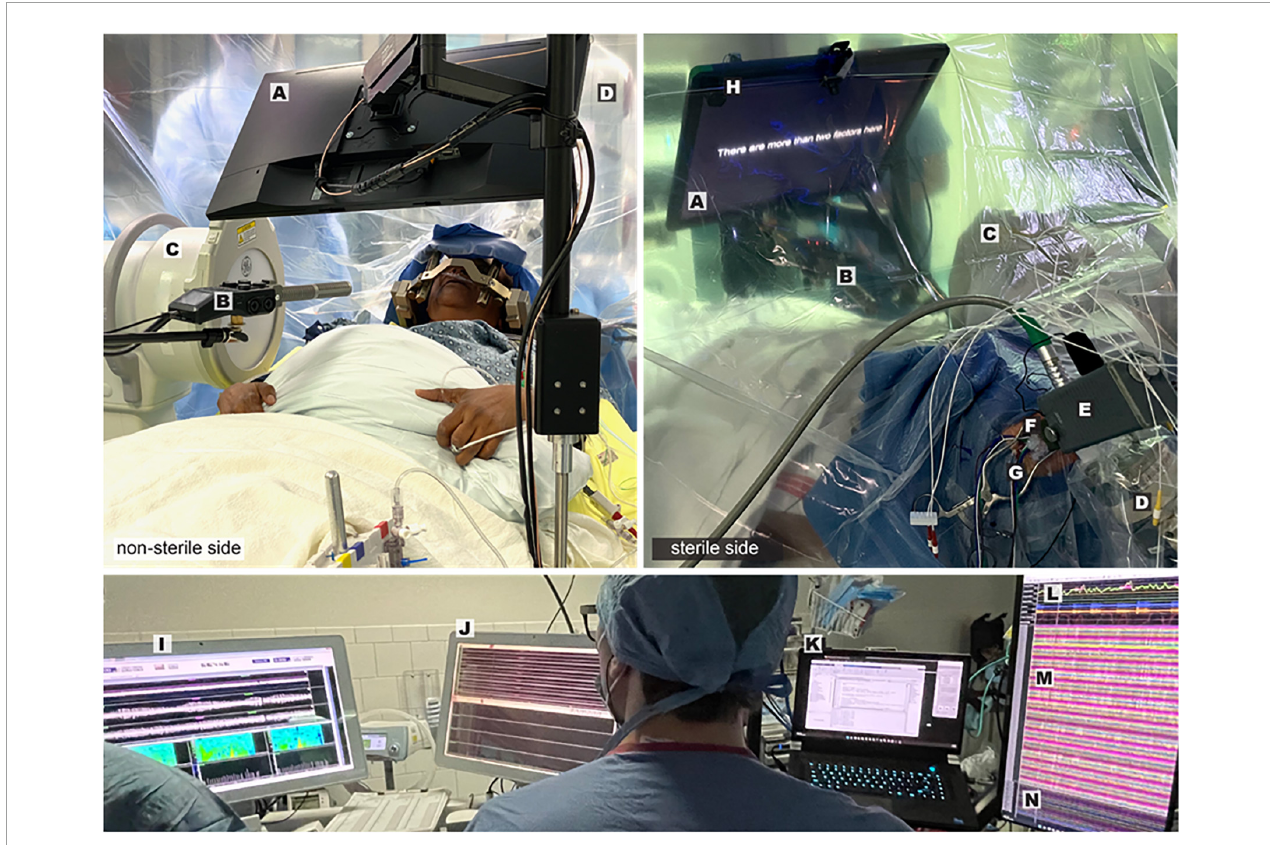
FIGURE3 Intraoperative speech production research employing simultaneous cortical and subcortical recording–Views from the non-sterile (left panel) and sterile (right panel) sides of the operative drape show important components of the experimental and clinical set-up: Presentation monitor displaying a sentence stimulus (A) , boom microphone and recorder (B) , fluoroscopy machine (C) , robotic stereotactic arm (D) , microdrive (E) , tissue glue-filled 14 mm burr hole (F) , exiting wires from ECoG electrode strips (G) , photodiode (H) . Visualization of multiple synchronized recording streams is seen in the lower panel: clinical microelectrode signals (I) , macroelectrode signals and task triggers (J) , task control/data storage computer (K) , audio and respiratory signals (L) , ECoG signals (M) , DBS lead channels (N)